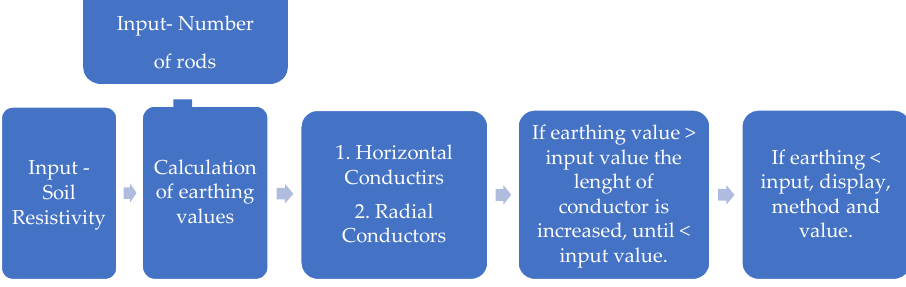
Figure 3. Process to calculate the earth values.